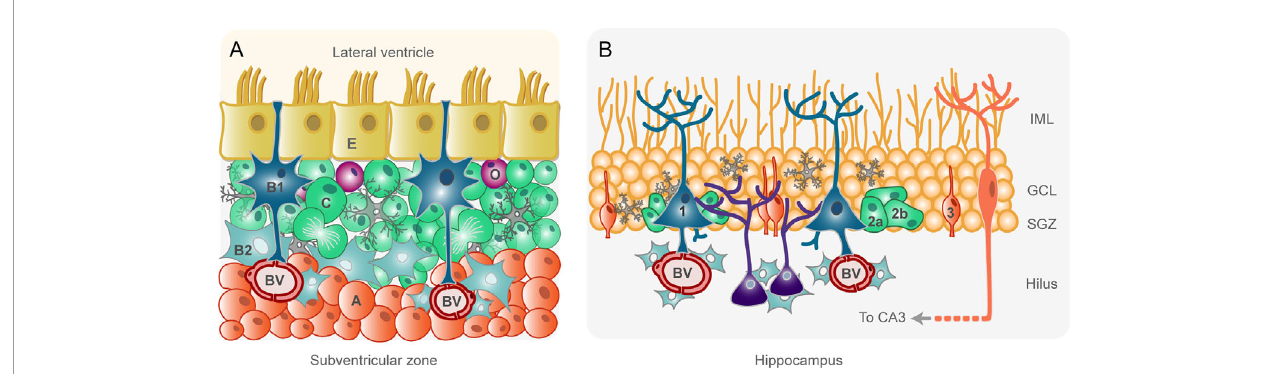
FIGURE 1 | Schematic drawings of the adult rodent subventricular zone (A) and hippocampus (B) . Equivalent cell types within each niche are represented in the same color. (A) . Ependymal cells (type E, in yellow) separate the cerebrospinal fl uid (CSF) in the lateral ventricle from the brain parenchyma. Type B1 cells (in dark blue) are neural stem cells with a basal process in contact with blood vessels (BV) and an apical process in contact with the CSF. B1 cells generate type C cells (in green) by asymmetric divisions. Type C cells are transit-amplifying intermediate progenitors that divide rapidly and produce neuroblasts (type A, in orange). Neuroblasts migrate in chains ensheathed by astrocytes toward the olfactory bulb, where they differentiate into mature interneurons. Type C cells can also produce oligodendrocyte progenitor cells (O, in purple). Other glial cells, such as astrocytes (type B2, in sky blue), and microglia (in gray) intervene in the control of subventricular zone neurogenesis. (B) . Neural stem cells (type 1, dark blue), located in the subgranular zone (SGZ) of the dentate gyrus of the hippocampus, harbor a basal process that contact BVs and numerous branches in the inner molecular layer (IML). Type 1 cells generate transit-amplifying non-radial type 2 cells (in green), which can be subdivided in type 2a and type 2b cells. Type 2 cells then give rise to a neuron-committed intermediate progenitor (type 3 cell, in orange). Type 3 cells generate fully functional granule cells in the granule cell layer (GCL) which, after maturation, develop dendritic arborization in the IML and axonal projection to the CA3. Microglia (gray) and astrocytes (sky blue) exert different roles in the control of